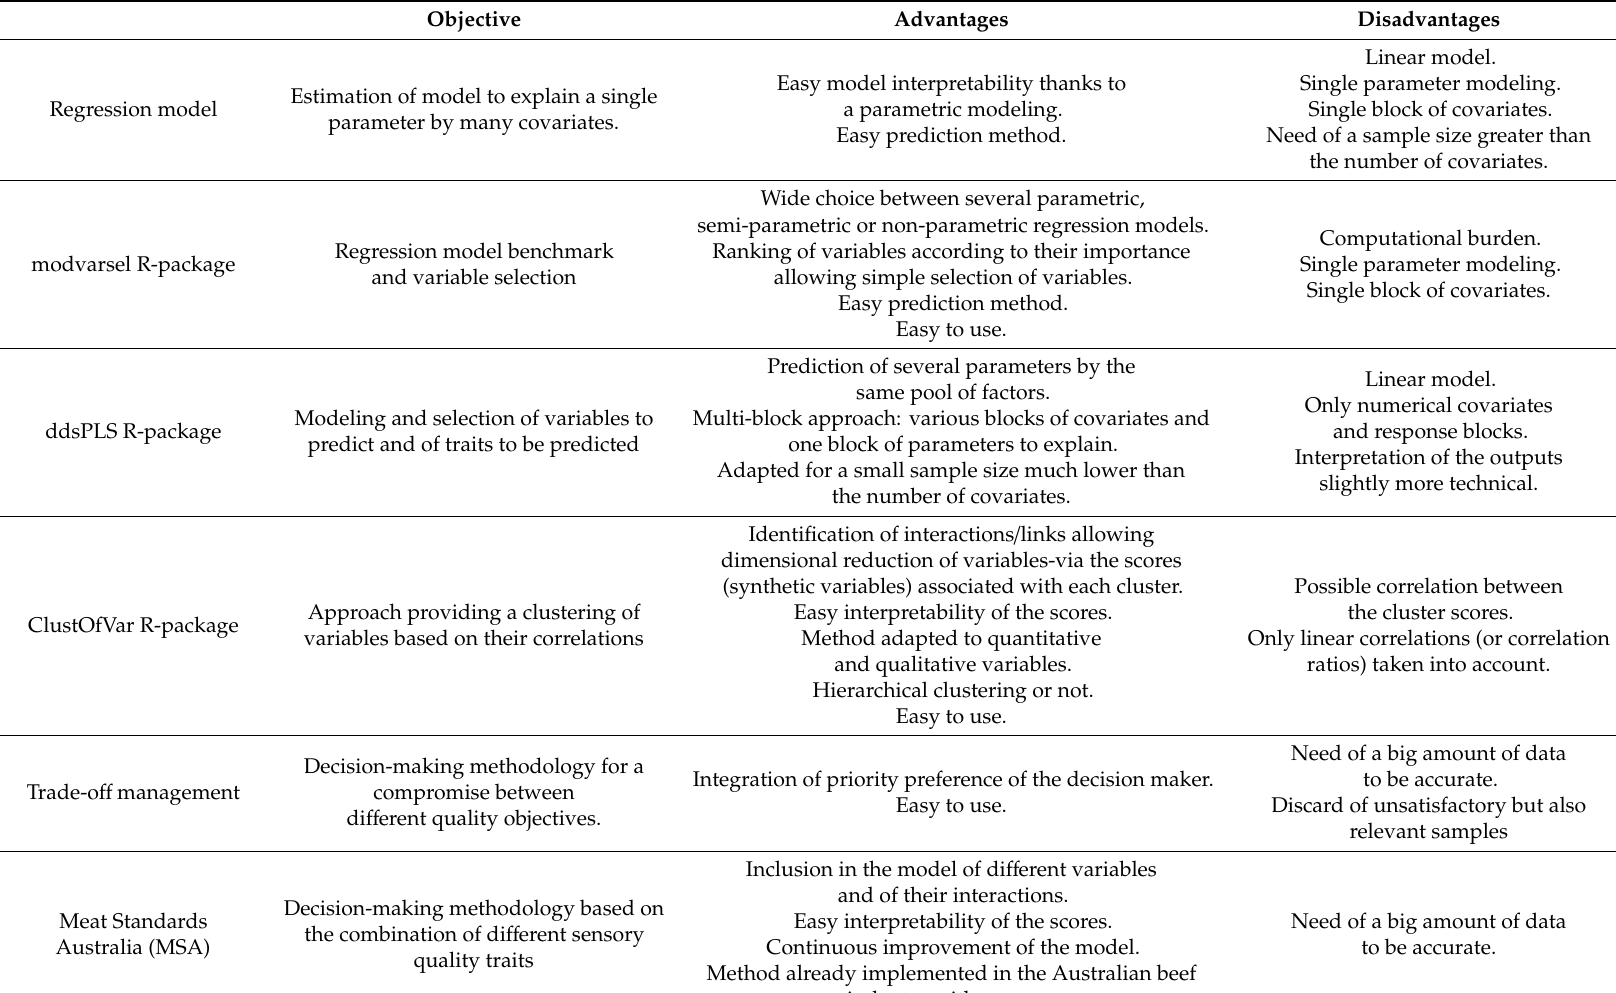
Table 2. Objectives, advantages and disadvantages of the statistical approaches developed in the present